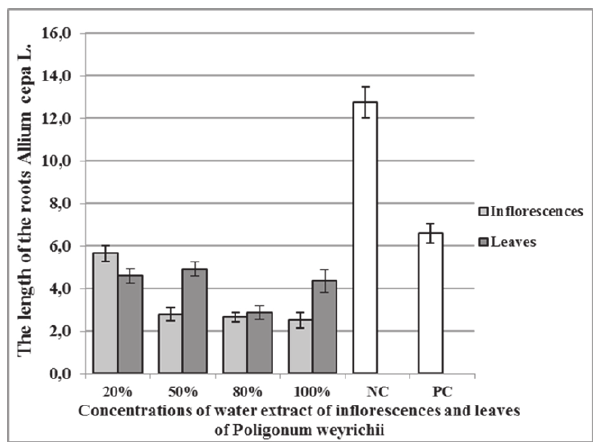
Figure 1. Dependence of the root length (mm) of Allium cepa L. on the concentration of aqueous extracts of P. weyrichii (exposure 48 h). Abbreviation: NC, negative control (distilled water); PC, pos- itive control (H2O2 1%). Abbreviations: NC, the negative control (distilled water); PC, the positive control (H 2 O 2